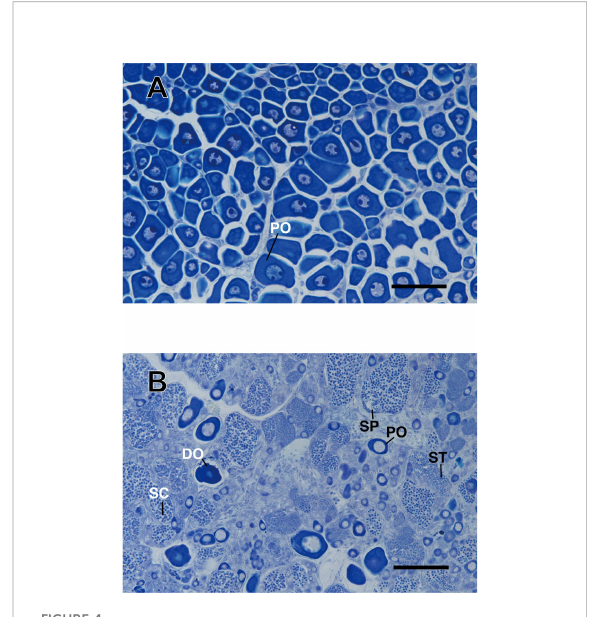
FIGURE 4 Conversion in the gonadal histology of the semi-gonadectomized P. sieboldi . Histological changes were evaluated in semi- gonadectomized fi sh, prior to induction of sex change. Images from (A) the beginning and (B) the end of the experiment are shown. Sex changes were induced in fi sh after semi-gonadectomy and placed in a 500 L tank during the pre-spawning season. Black arrow; sperm, white arrow; oocyte. PO, perinuclear oocyte; DO, degenerated oocyte; SC, spermatocytes; ST, spermatid;, SP, sperm; Bar length, 100 mm.